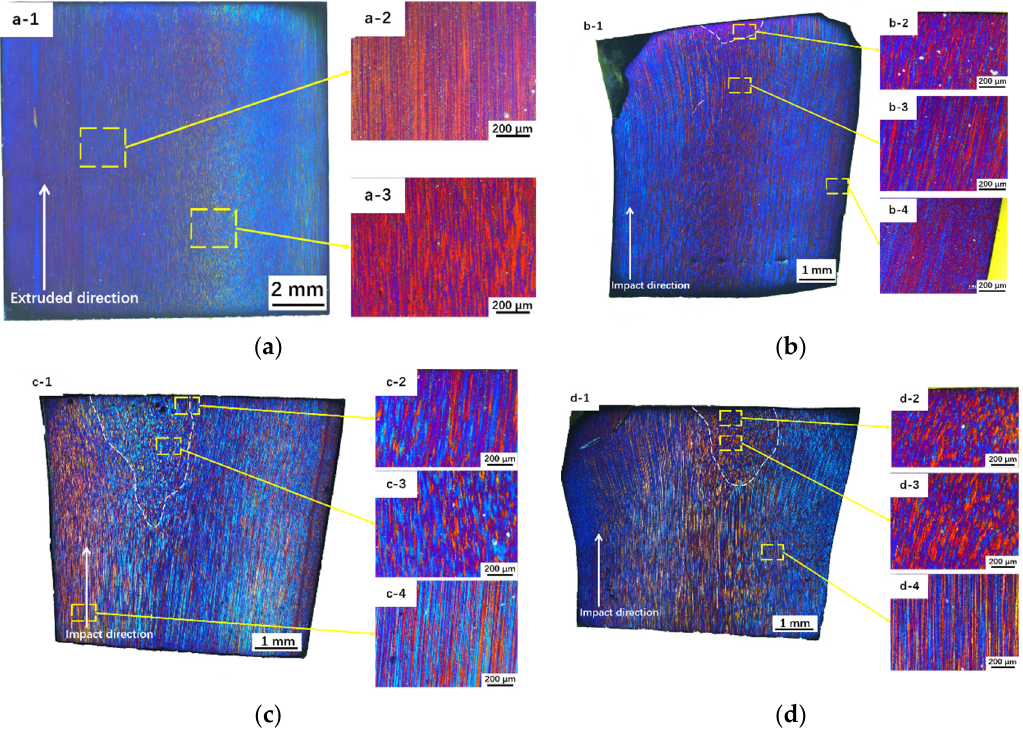
Figure 9. Polarized metallographic structure of the specimens after impact at different velocities: ( a ) AOEP, ( a-2 ) and ( a-3 ) are enlarged pictures of ( a-1 ), which show the typical elongation grains along the extrusion direction; ( b ) v = 159.4 m/s; ( c ) v = 190.4 m/s; and ( d ) v = 221.7 m/s; After impact, the specimen mainly contains two regions: severe deformation region and small deformation zone. ( b-2 , b-3 , b-4 ) are the enlarged pictures of the severe deformation region, the boundary and the small deformation zone in ( b-1 ), respectively. ( c ) and ( d ) are the same as ( b